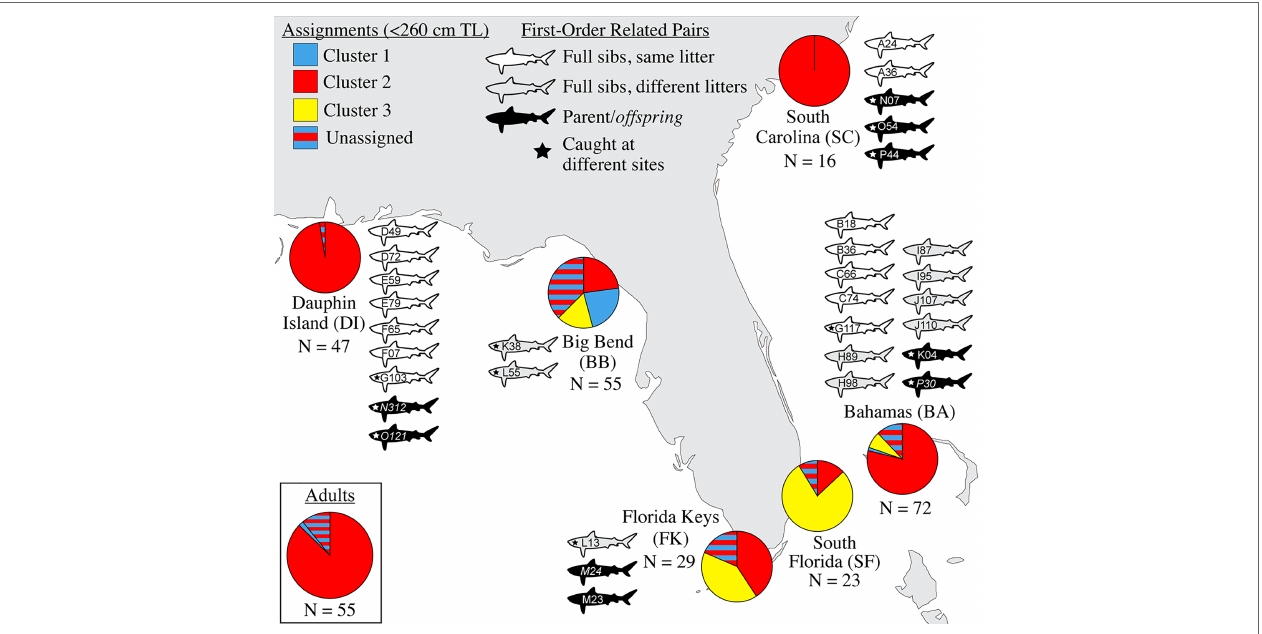
FIGURE 2 | Genetic assignments and related pairs, by sampling site. Pie charts at sampling sites indicate the relative proportion of population ancestry among individuals <260 cm TL that assigned strongly to three genetic clusters (C1-C3), with the remaining individuals that could not be strongly assigned forming a separate “unassigned” group. The inset pie chart shows genetic assignments of potential reproductive migrants ≥300 cm TL for all sites together. Shark icons represent the catch location of individuals related by ~50% (first-order kin: full sibling or parent-offspring); the letters and numbers identify them as the related pairs described in Table 3 . N, sample